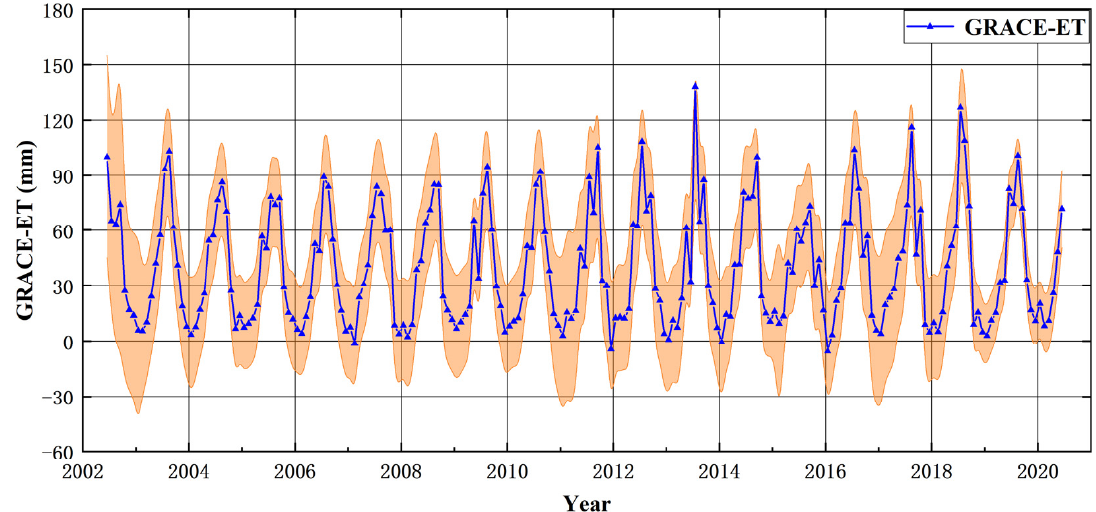
Figure 4. The ET and its uncertainty estimated by Gravity Recovery and Climate Experiment (GRACE)/GRACE Follow-On (GRACE/GRACE-FO) based on the water budget equation. Orange shadow represents the uncertainty of the ET. GRACE—Gravity Recovery and Climate Experiment.